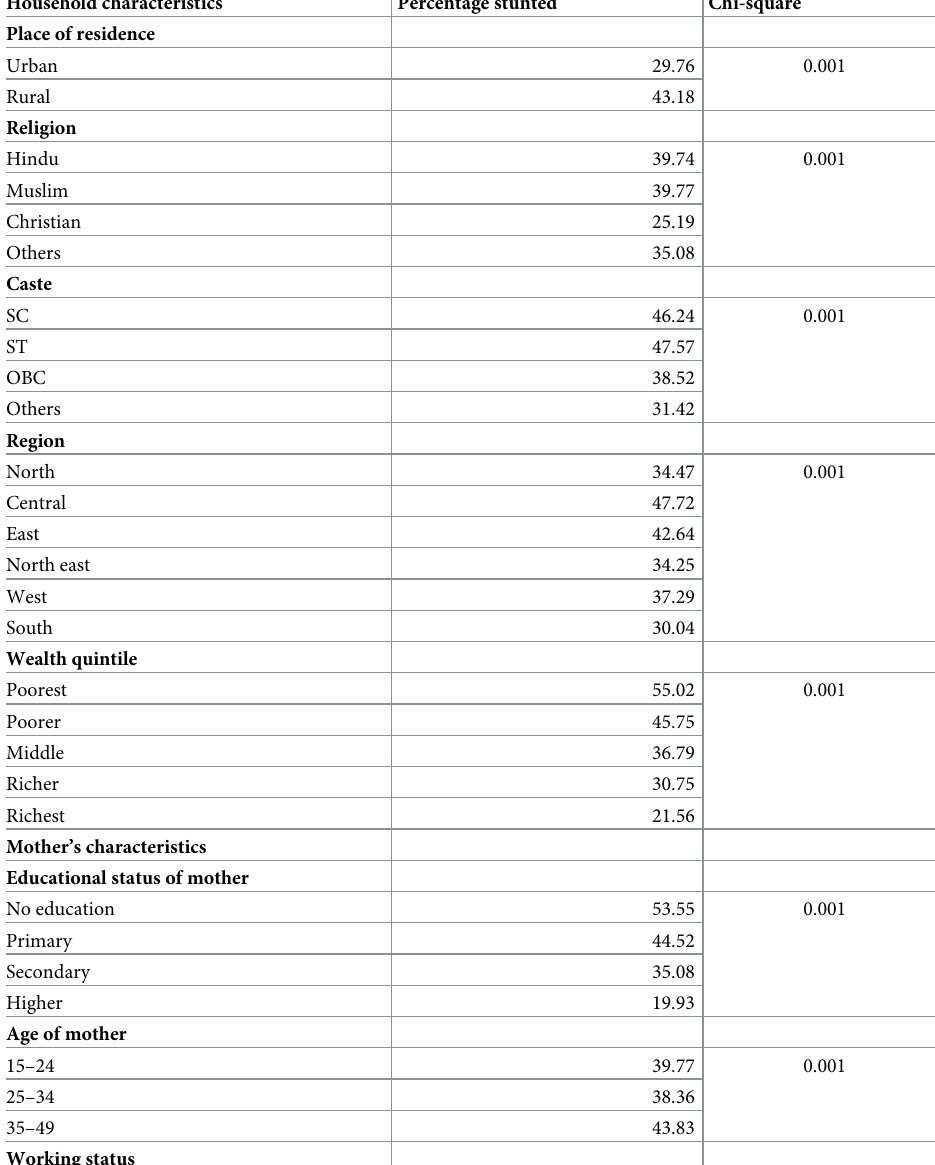
Table 4. Bivariate analysis of background variables by stunting in India, NFHS-4, 2015–16. Household characteristics Percentage stunted